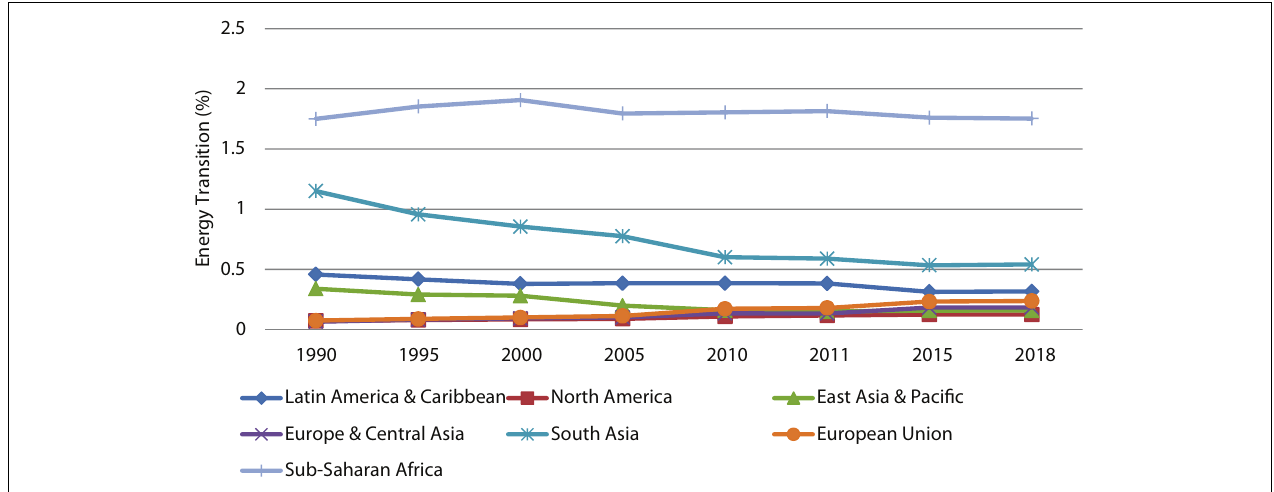
FIGURE 1 | Energy Transition in the different regions, 1990–2018%. Source: Authors’ compilation based on data from the World Bank and BP’s 2019 statistical report.